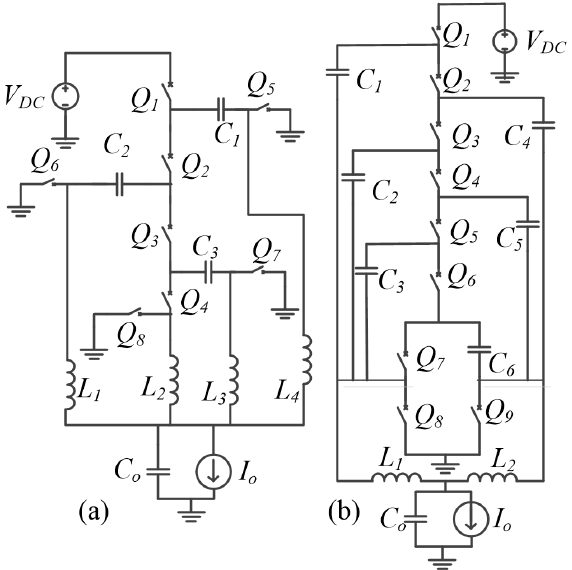
Figure 11. Multi-phase converters with ( a ) four and ( b ) two output